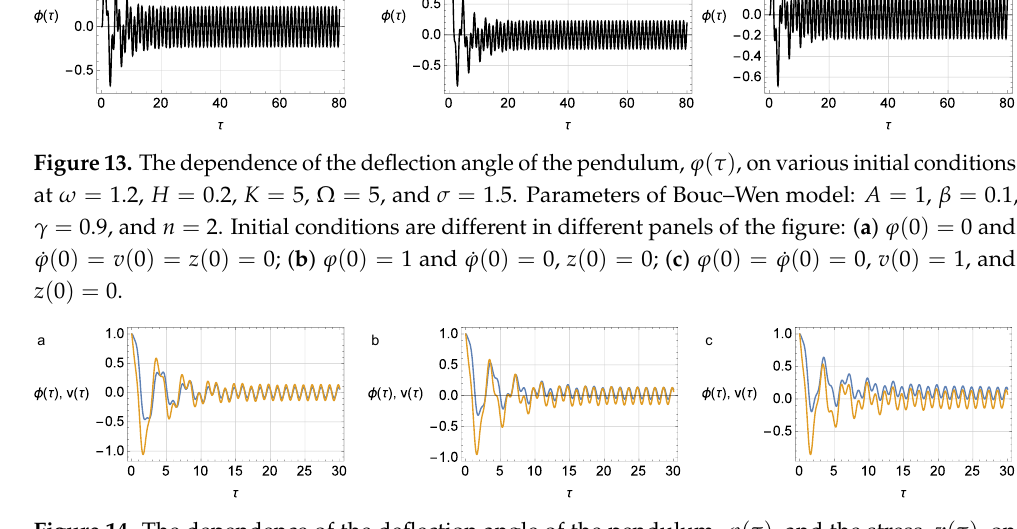
Figure 14. The dependence of the deflection angle of the pendulum, ϕ ( τ ) , and the stress, v ( τ ) , on the dimensionless time at different values of the coefficient at the hysteresis term; ω = 1.2, K = 2, Ω = 5, and σ = 1.5. Parameters of Bouc–Wen model: A = 1, β = 0.1, γ = 0.9, and n = 3 and initial conditions ϕ ( 0 ) = 1, v ( 0 ) = 1, and ( a ) H = 0.0, ( b ) H = 0.5, or ( c ) H = 1. The hysteresis curve in coordinates ( ϕ , z ) is shown in Figure